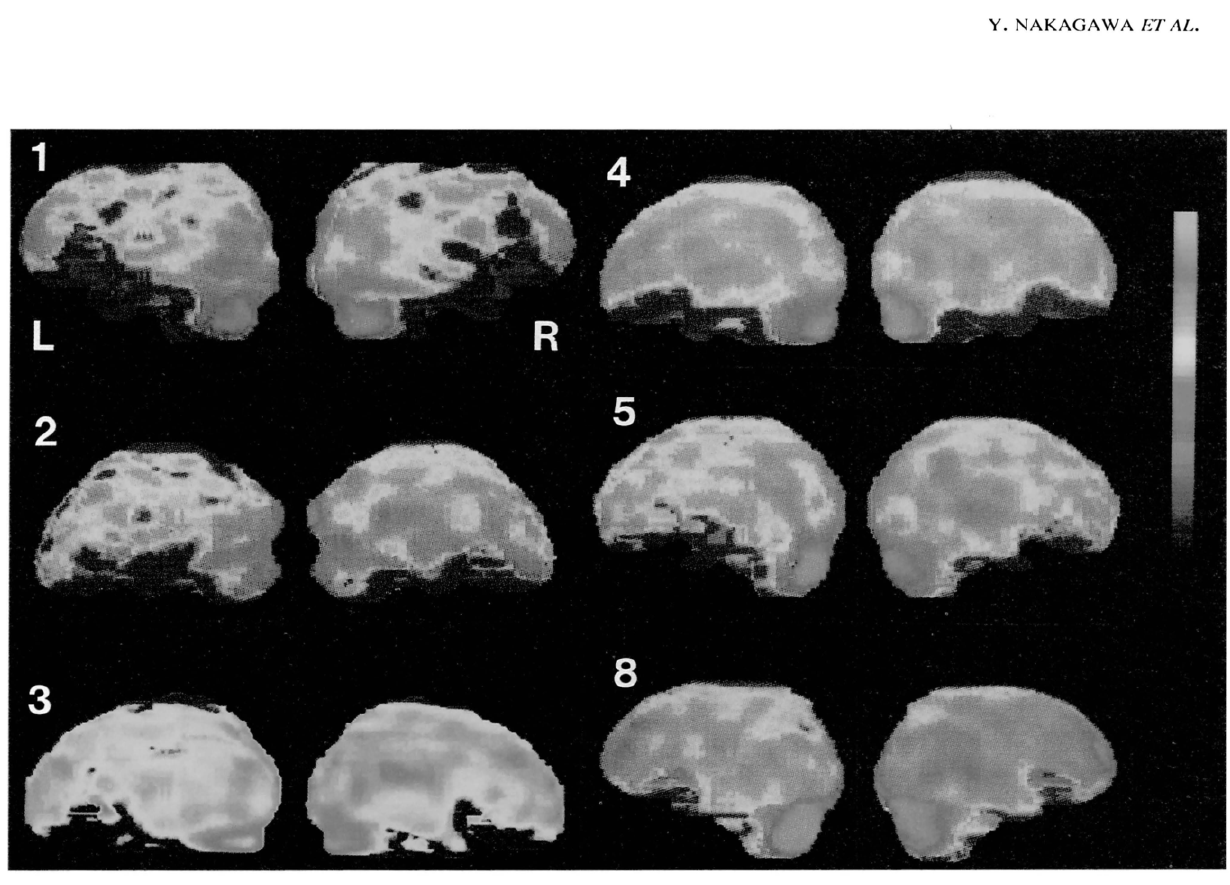
FIG. 2. Three-dimensional surface single photon emission computer tomography scans of patients A 1, A2, A3, M , AS and A8.